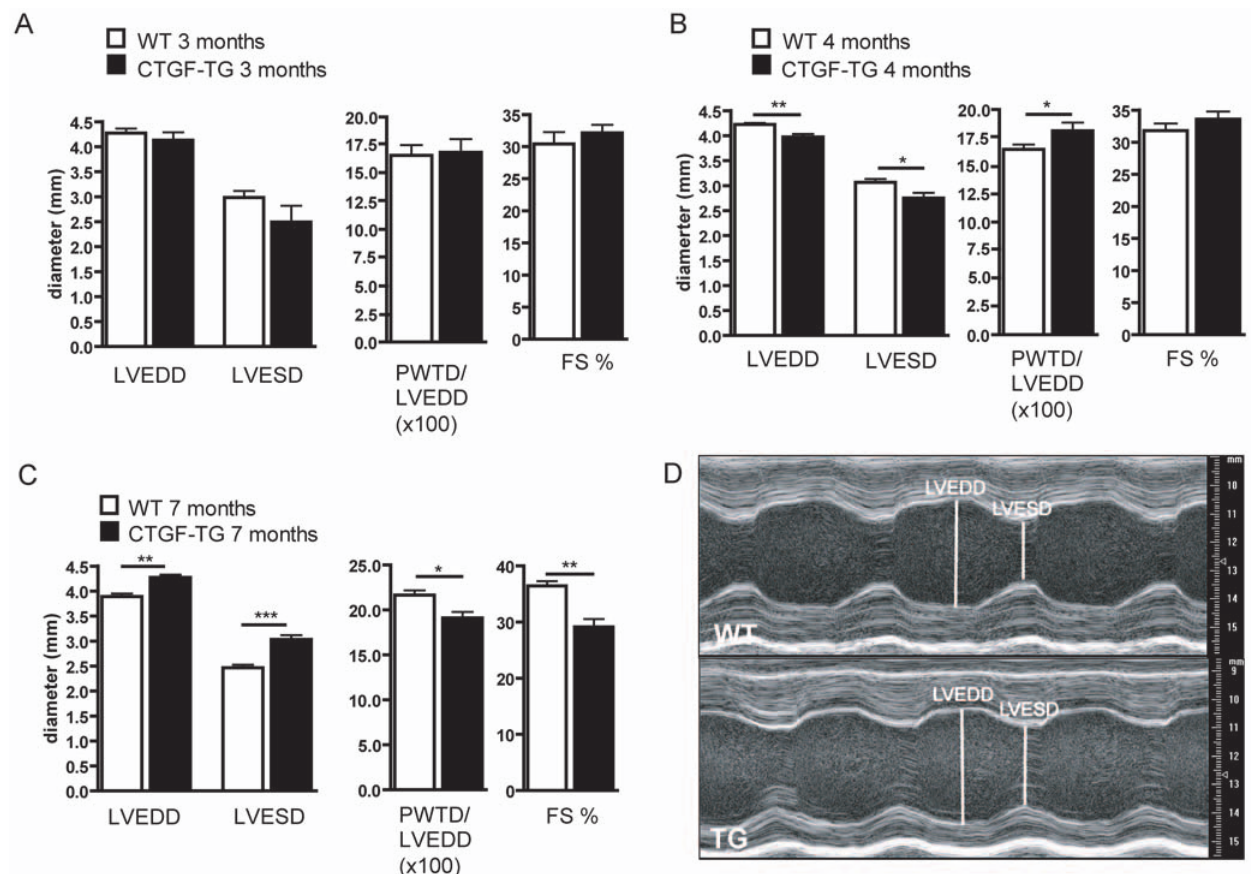
Figure 2. Characterization of CTGF-TG mice of different ages by echocardiography. (A, B, C) Measurements of LVEDD, LVESD, calculated ratio of PWD/LVEDD and FS of 3-months-old mice (A, WT n=9 TG n=7), 4-months-old mice (B, WT n=10, TG n=9) and 7-months-old mice (C, WT n=7, TG n=6). * P , 0.05; ** P , 0.01; *** P , 0.001. (D) Examples of M-mode echocardiography in CTGF-TG and WT mice at age of 7 months.